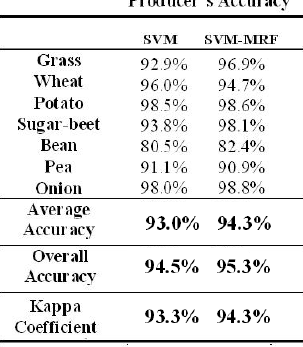
Table 3. Accuracy comparison for SVM and SVM-MRF